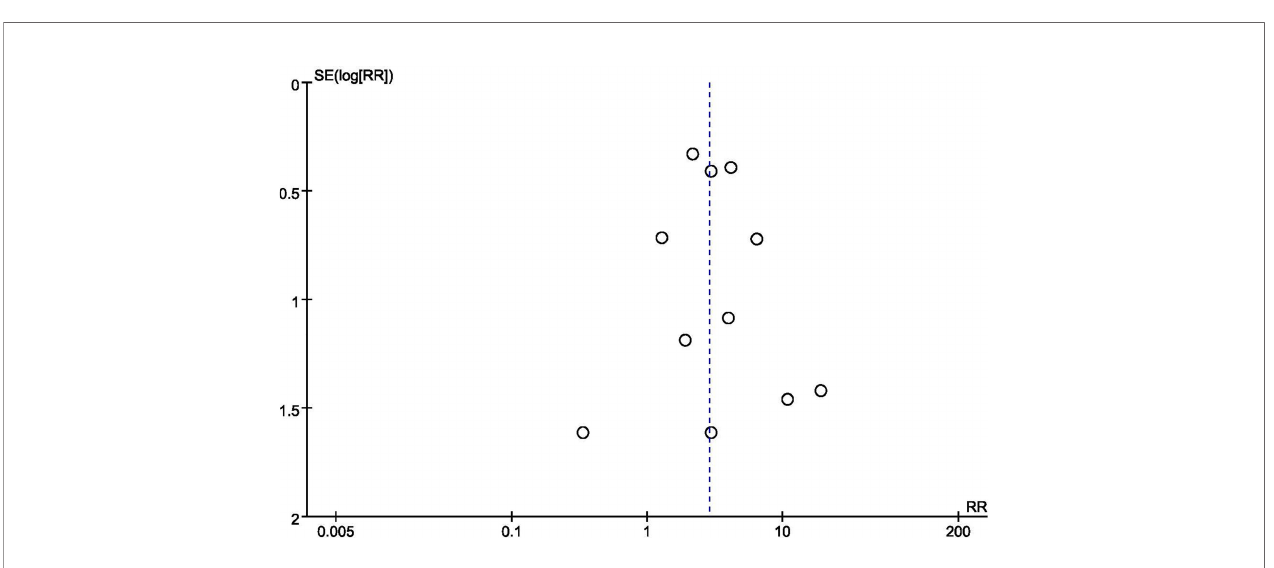
FIGURE 4 | Forest plots of meta-analysis for (A) AMH, (B) FAI, (C) SHBG, and (D) T. AMH, Anti-Müllerian Hormone; FAI, free androgen index; SHBG, sex hormone-binding globulin; T, testosterone.